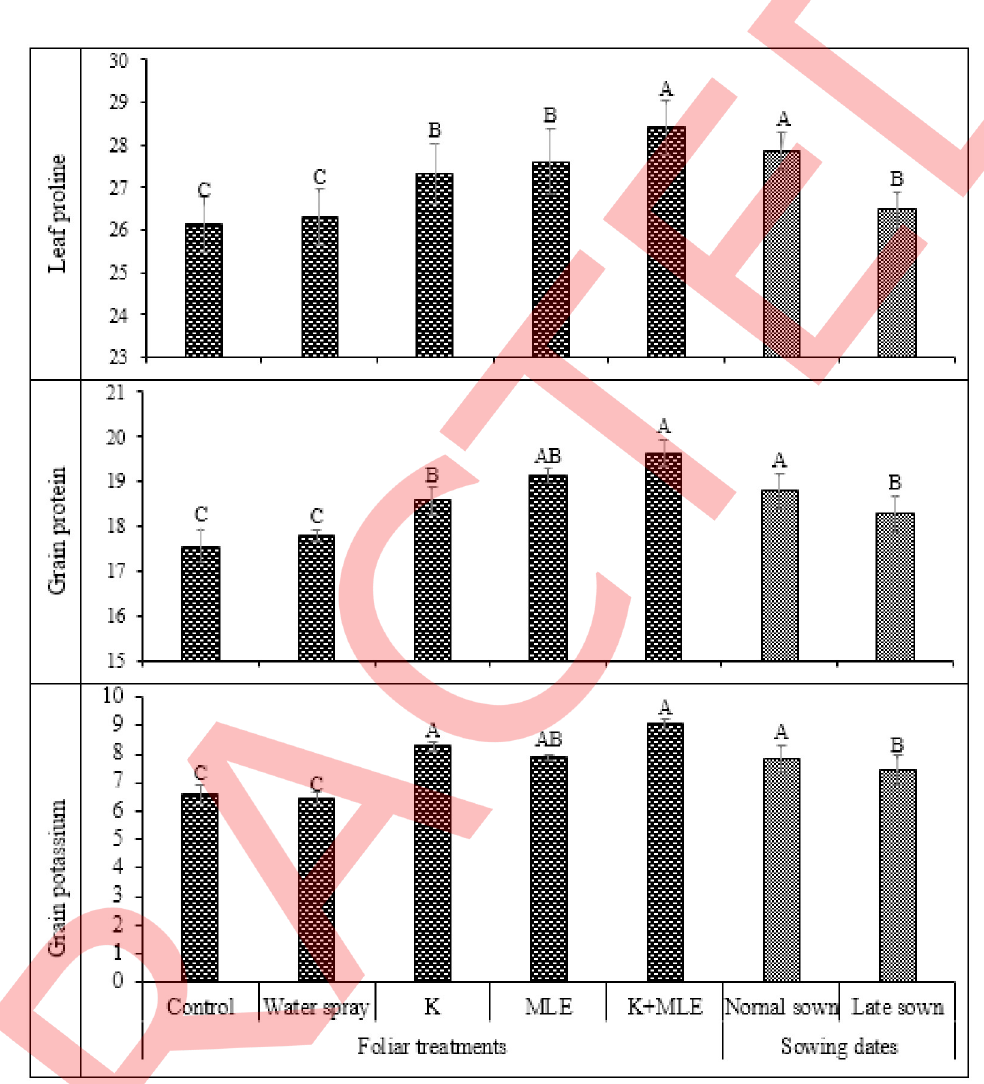
Fig 5. Impact of foliar applied K and MLE on leaf proline (a), grain protein (b) and grain potassium contents of early and late sown kabuli chickpea.